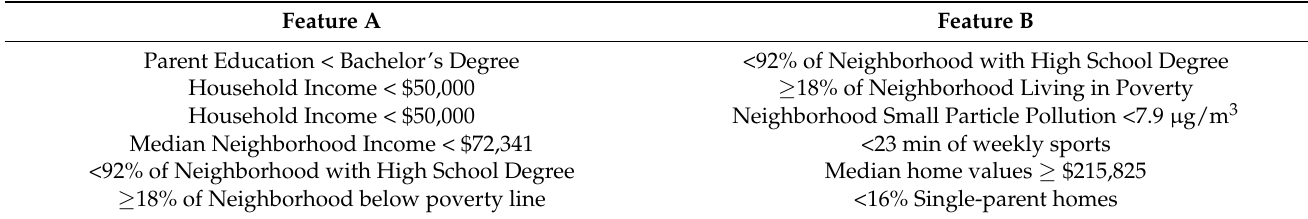
Table 2. Decision Rules and Median Splitting Values for each interacting